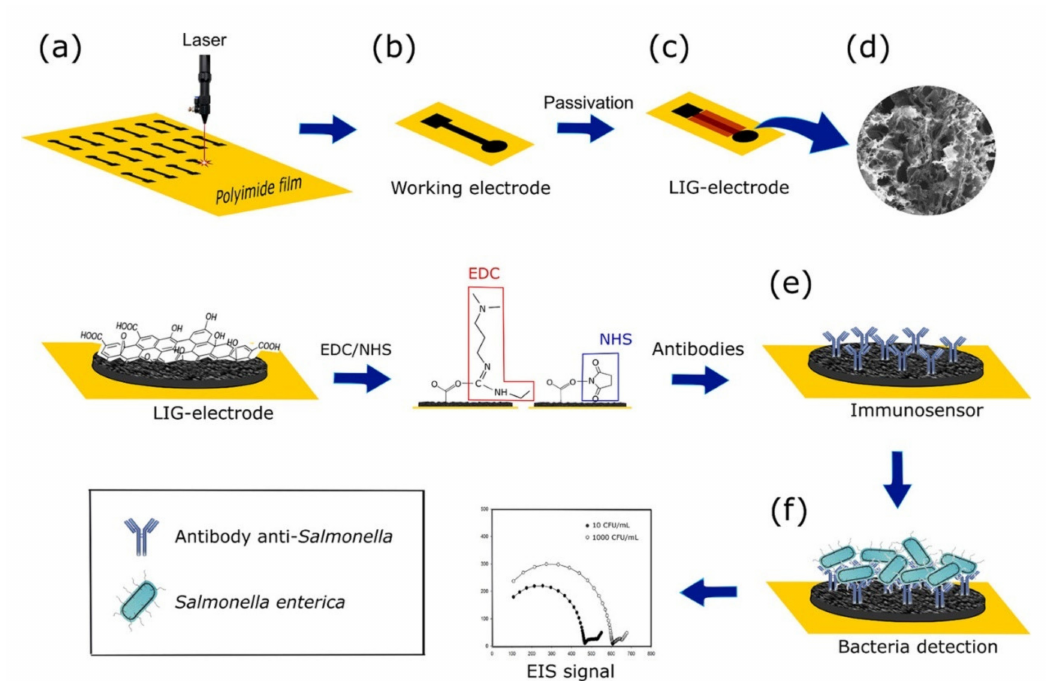
Figure 3. Schematic diagram of a label-free electrochemical immunosensor for Salmonella detection. ( a ) label-free laser- induced graphene processing, ( b ) working electrode, ( c ) passivation of the working electrode, ( d ) SEM image showing, ( e ) antibodies immobilization, ( f ) Salmonella binding to the electrode